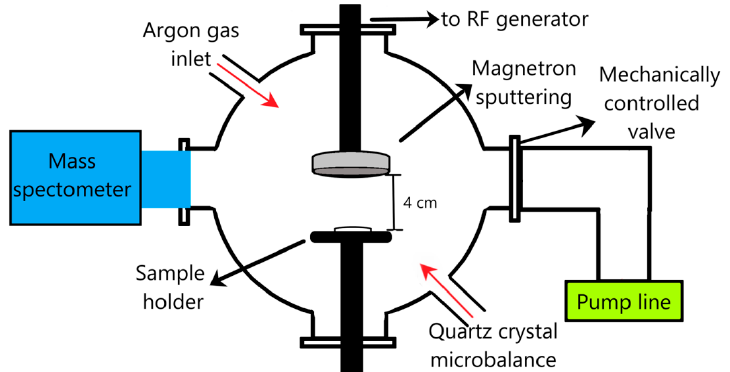
Figure 1. Experimental